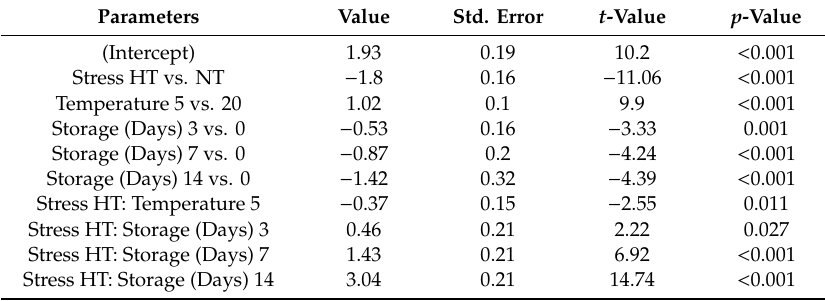
Table 3. Predictive factors for the invasiveness of bacteria identified by the Linear Mixed Effects Model.